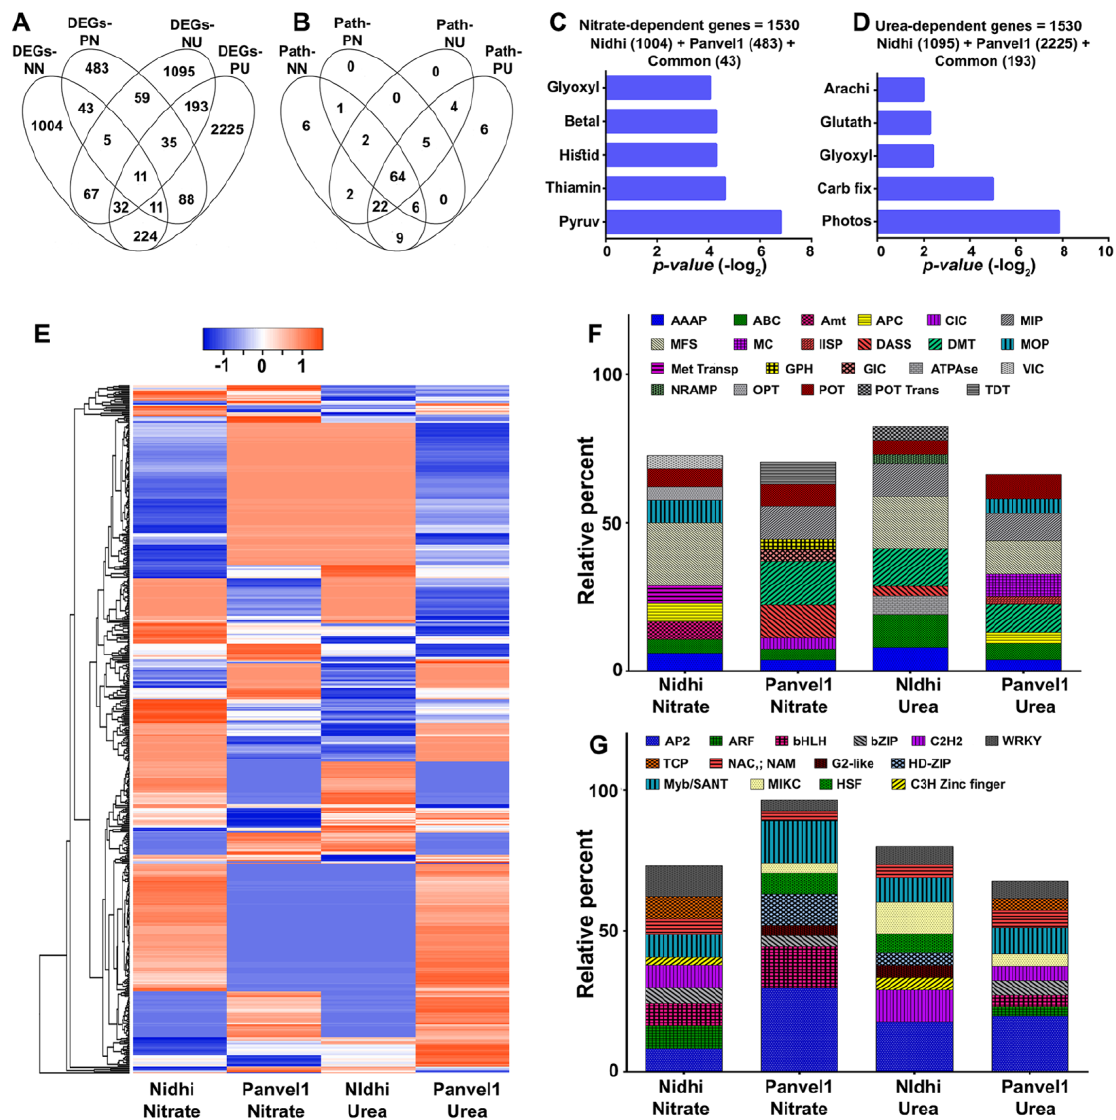
Figure 6. Common and specific nitrate − and urea − responsive genes and pathways in Nidhi and Panvel1. Venn diagrams represent the specific and overlap of DEGs ( A ) and all the assigned path- ways ( B ) in low nitrate versus low urea responses in both the genotypes. Combined N − responsive genes and their top enriched pathways annotations are shown for nitrate ( C ) and urea ( D ). ( E ) Hi- erarchical clustering of common N − responsive genes from Nidhi shows distinct pattern in Panvel1. Each column represents a single N (nitrate or urea) treatment in a particular genotype (Nidhi or Panvel1), whereas each row represents a DEG. Stacked bar graph represents the relative percentage of top 10 enriched transporters ( F ) and transcription factors ( G ) responsive to nitrate [16] and urea (current study). The X − axis represents the nitrate or urea treatment in Nidhi or Panvel1. Details of genes and pathways are given in Supplementary Table S16. DEGs − NN, DEGs − Nidhi nitrate;